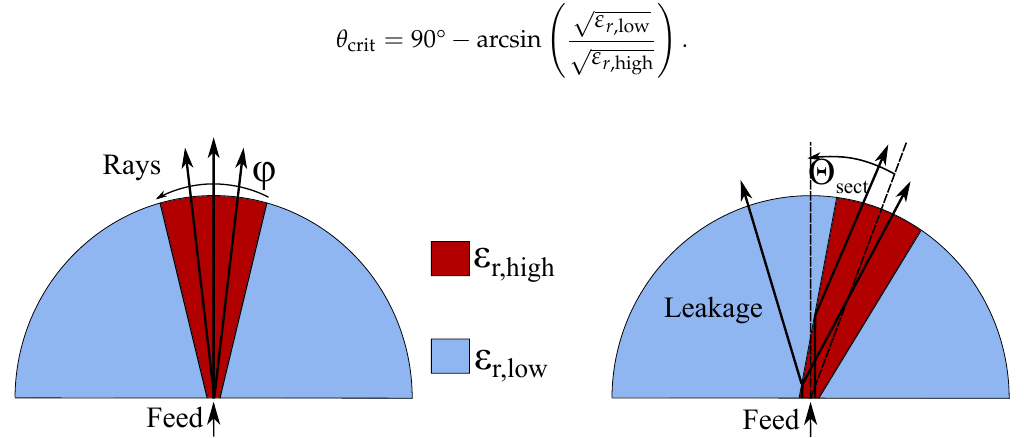
Figure 39. Beam steering principle of lateral wave antennas represented by